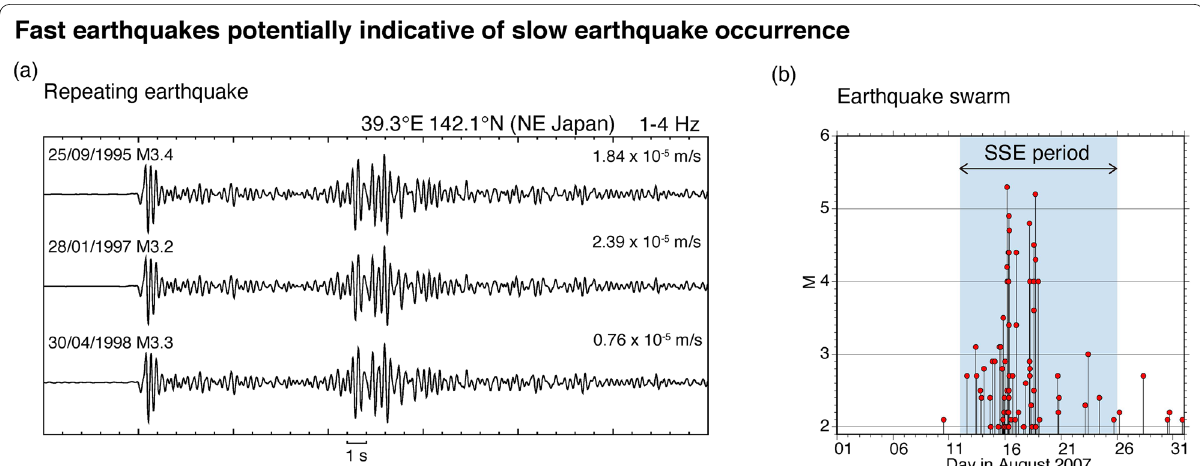
Fig. 4 Fast earthquakes potentially indicative of slow earthquake occurrence. a Observed waveforms of repeating earthquakes. These repeating earthquakes were observed off Kamaishi in the northern Japan Trench (Igarashi et al. 2003). b Magnitude–time diagram for an earthquake swarm accompanying an SSE. This earthquake swarm was observed during the period of the 2007 SSE off the Boso Peninsula in the Sagami Trough, eastern Japan (Fukuda